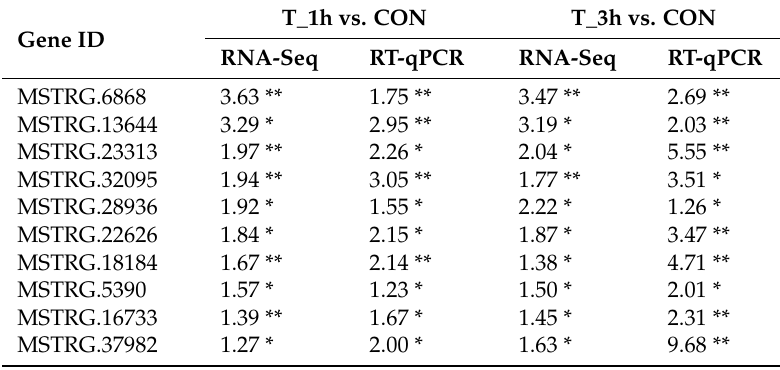
Table 4. Expression patterns of the 10 mRNAs selected for RT-qPCR